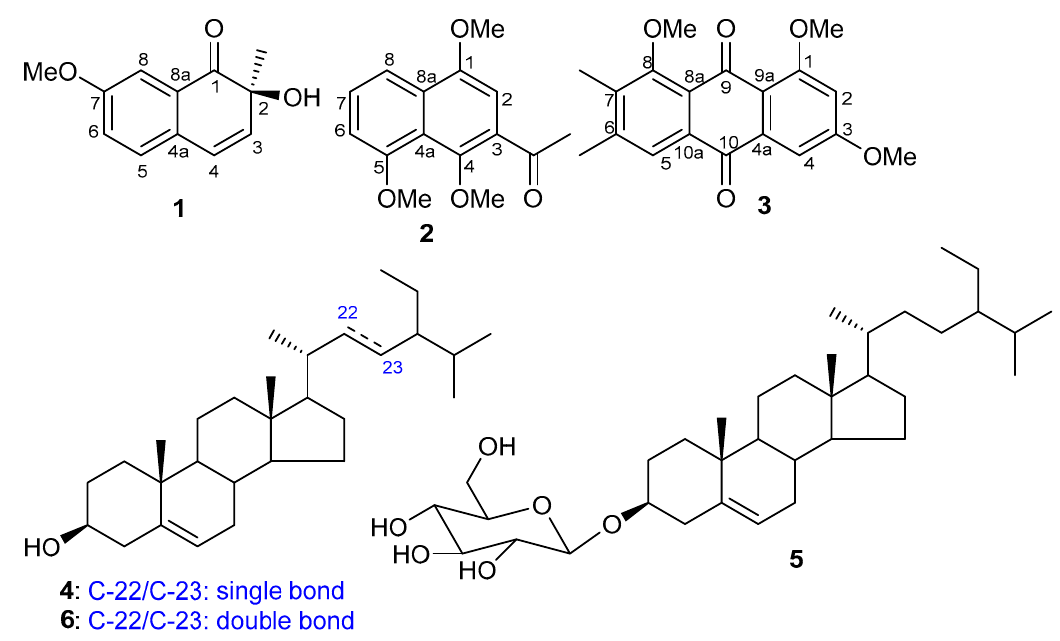
Figure 2. Structures of compounds isolated from C. intybus .